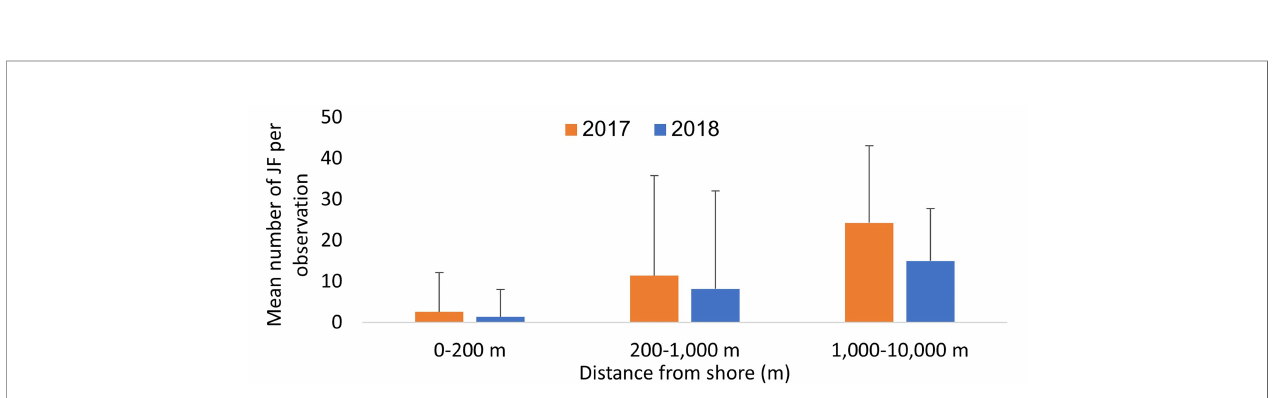
FIGURE 3 | Mean number of jelly fi sh per observation (JSI) in inshore (0-200 m, n=612) mid-range (200 m – 1,000 m, n=71) and offshore (1,000 m – 10,000 m, n=17) observations in the two study